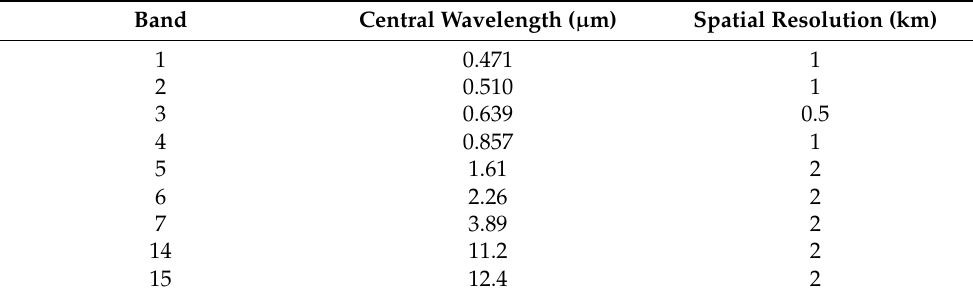
Table 2. Basic specifications of AHI bands used in this